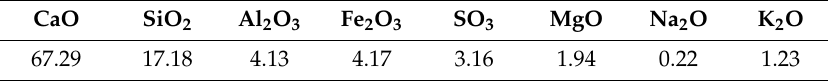
Table 1. Chemical composition of ordinary Portland cement (wt.%).